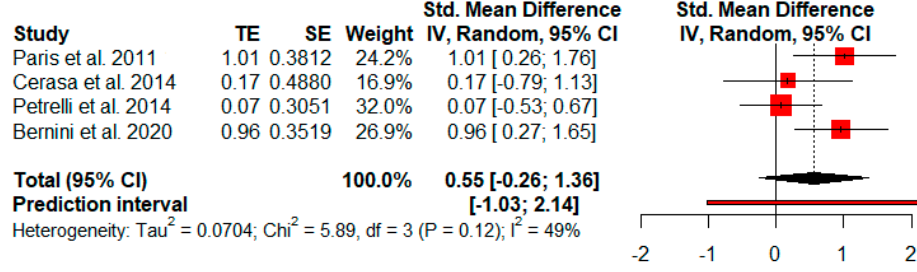
Figure 3 . Effectiveness of cognitive rehabilitation in global cognitive status.